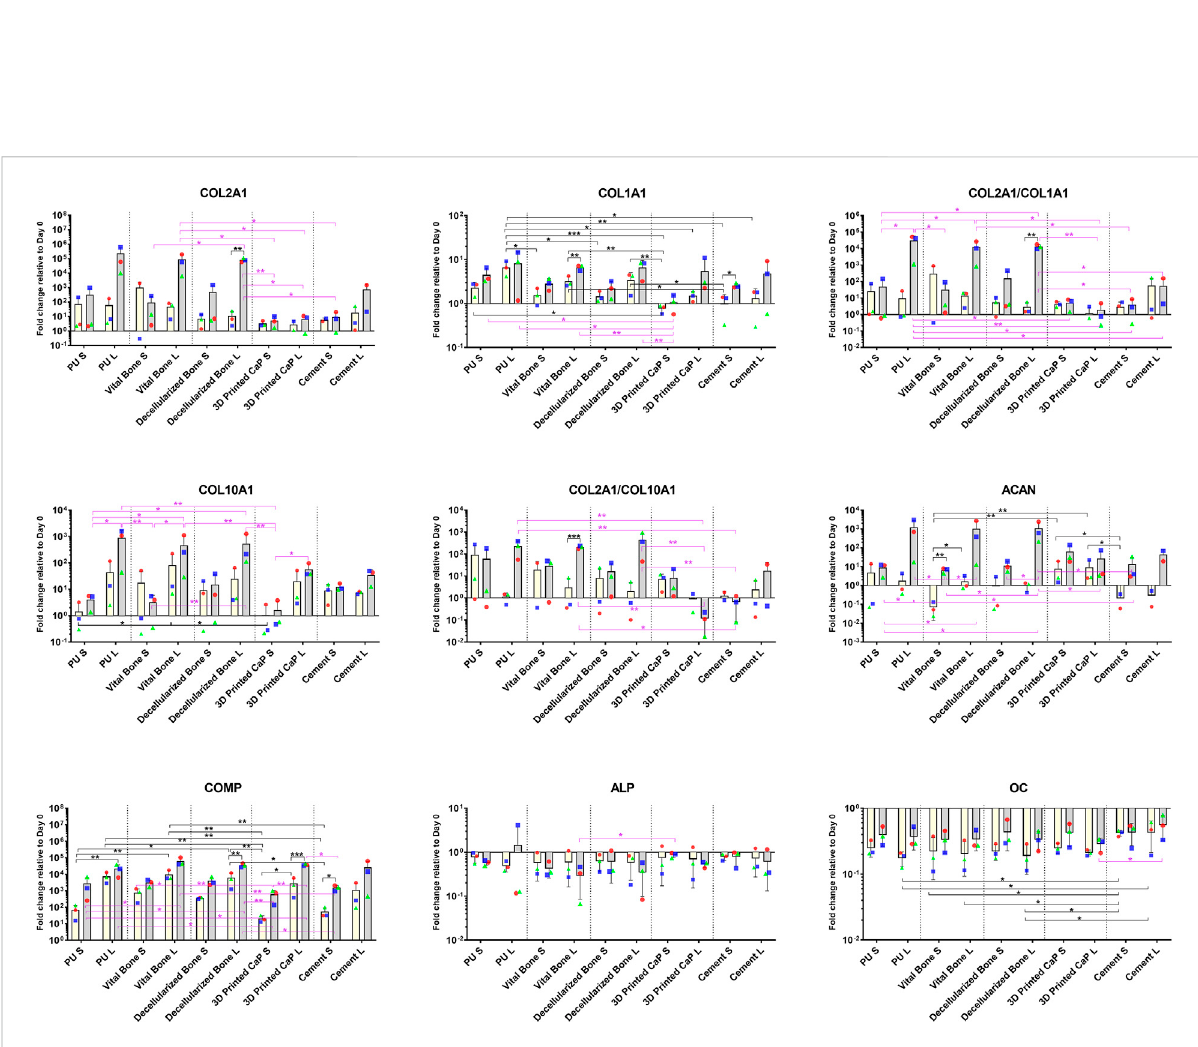
FIGURE 3 Gene expression of cartilage (COLA2A1, COMP, ACAN), hypertrophy (COL10A1) and bone (COL1A1, ALP, OC) related genes. Load generally led to an increase in all markers except ALP. Load combined with the PU, vital bone, and bone dead groups led to particularly favourable ACAN expression and improved COL2A1/COL1A1, COL2A1/COL10A1 ratios. * p < 0.05, ** p < 0.01, *** p < 0.001. Black signi fi cance bars designate differences on Day 7 among all groups or day 7 vs. day 28 within the same group. Purple signi fi cance bars designate differences on Day